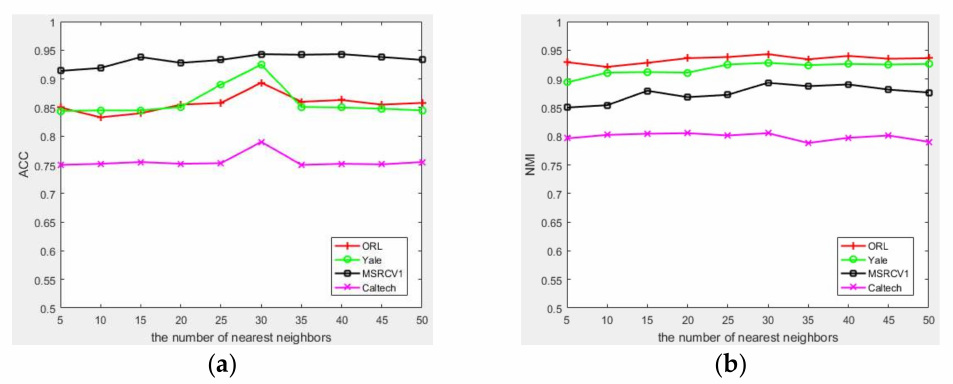
Figure A1. Variation of ACC and NMI with different numbers of nearest neighbors on four benchmark datasets, ( a ) ACC, ( b )